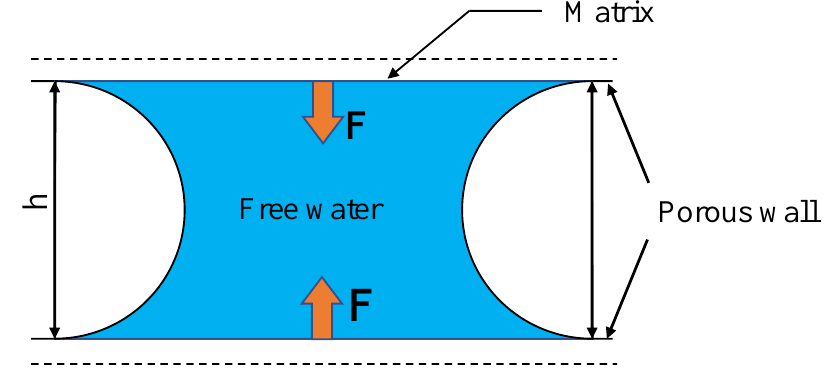
Figure 19. Stefan effect of concrete pore water.